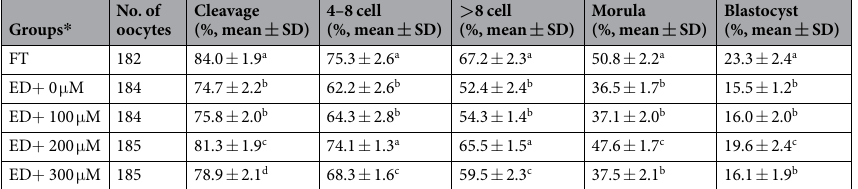
Table 1. Effect of different concentrations of TUDCA addition during embryo culture on the development of embryos. Note: Different letters within the same column indicate statistical differences at p < 0.05 by one-way ANOVA followed by the LSD multiple comparison test (N = 8). FT: blastocysts developed from conventional freeze-thaw boar spermatozoa without TUDCA-treatment; ED + 0 μ M, ED + 100 μ M, ED + 200 μ M and ED + 300 μ M: blastocysts developed from evaporatively dried boar spermatozoa with 0, 100, 200 and 300 μ M TUDCA-treatment,